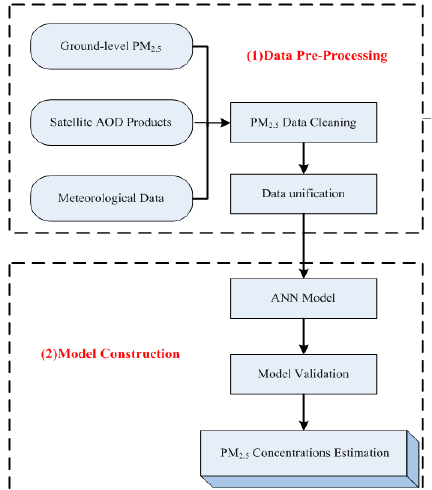
Figure 2. Flow chart showing approach for the estimation of the PM 2.5 . ANN: artificial neural network.